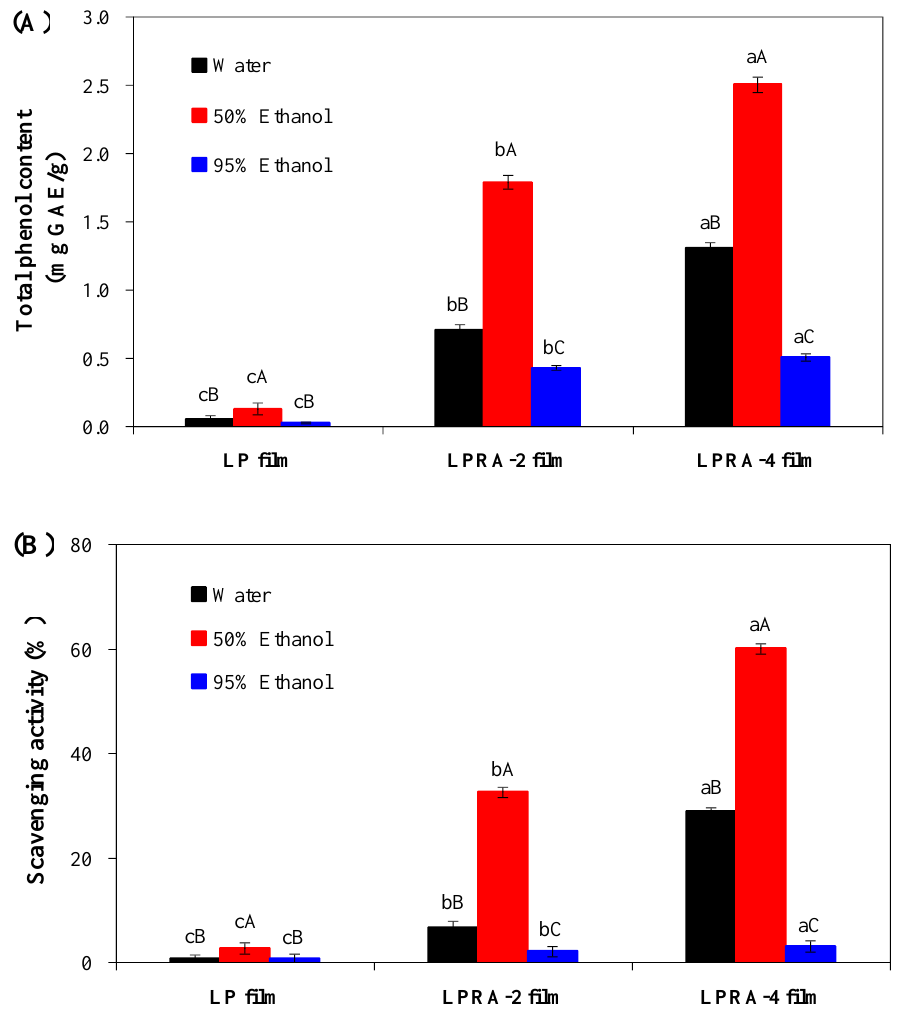
Figure 7. Total phenol content ( A ) and DPPH radical scavenging activity ( B ) released from LP film, LPRA-2 film, and LPRA-4 film into three different solvent systems. Values are given as mean ± standard deviation (n = 3 for total phenol content and DPPH radical scavenging activity). Different lower case letters indicate the statistically significant difference ( p < 0.05) within different films under the same solvent. Different upper case letters indicate the statistically significant difference ( p < 0.05) within the same film under different solvents.